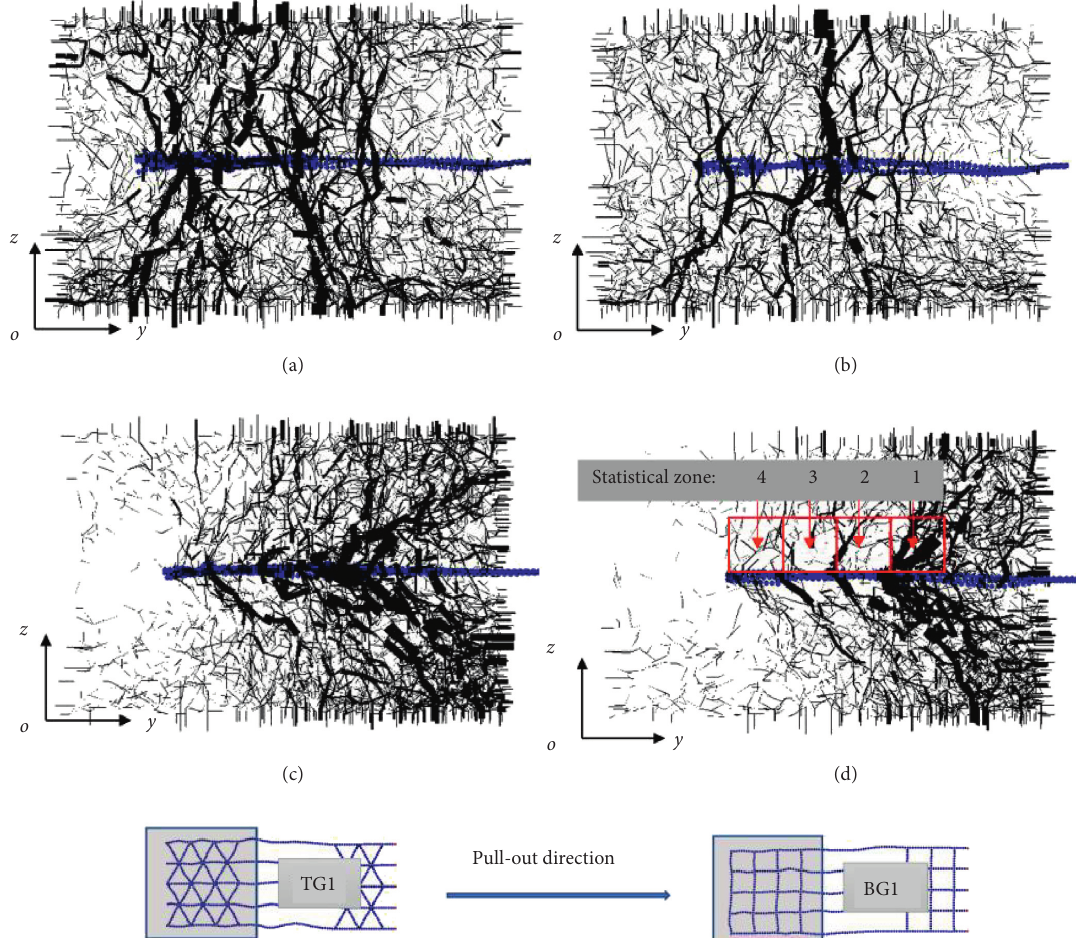
Figure 8: Normal contact force chain distribution for BG1 and TG1 under 20kPa normal stress. (a) Pull-out displacement � 0. (b) Pull-out displacement � 0. (c) Pull-out displacement � 36mm. (d) Pull-out displacement � 36